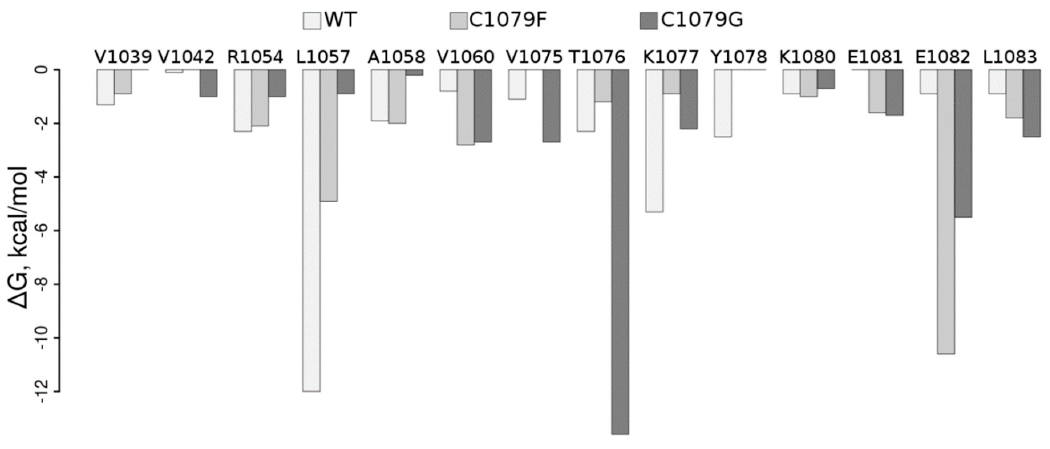
Figure 3. Molecular mechanics-generalized borne surface area (MM-GBSA) free energy per residue decomposition ( Δ G, kcal/mol). Residues in the figure revealed the free energy of contact with the residue in position 1079 to be lower than 0.6 kcal/mol (~RT, T = 300 K) in at least one of the simulations. In particular, contact of the residue in position 1079 with Leu1057 and Lys1077 is weakened by both mutations; contact with Glu1082 is stabilized upon both mutations, with a more pronounced